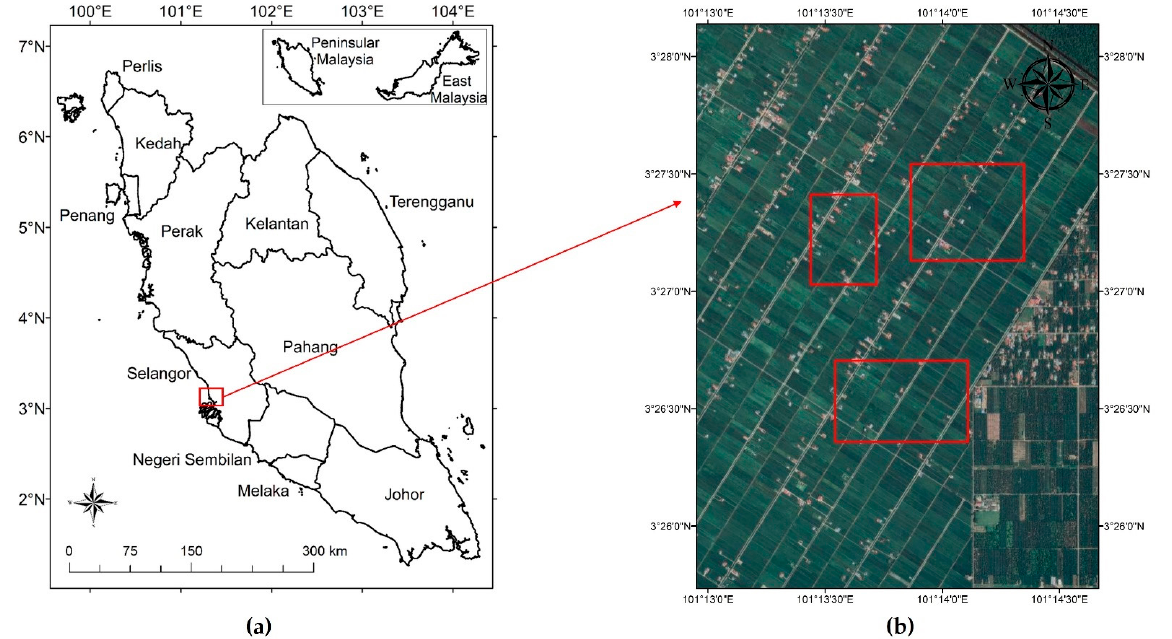
Figure 1. The location of the study area: ( a ) map of Malaysia; ( b ) aerial images of the study area. The red square shows the location of the several paddy fields chosen.